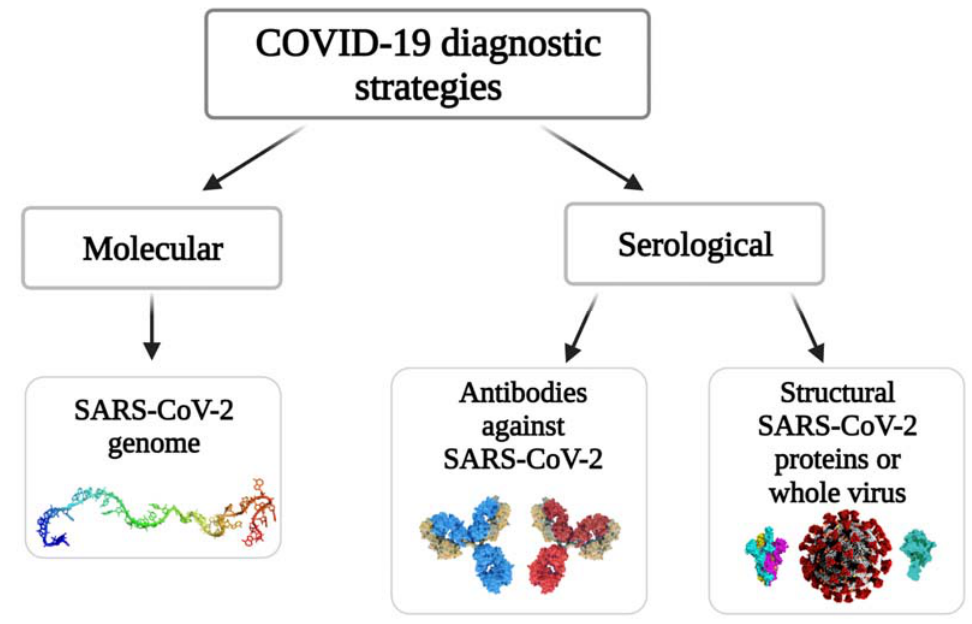
Figure 1. The strategies of COVID ‐ 19 diagnosis.